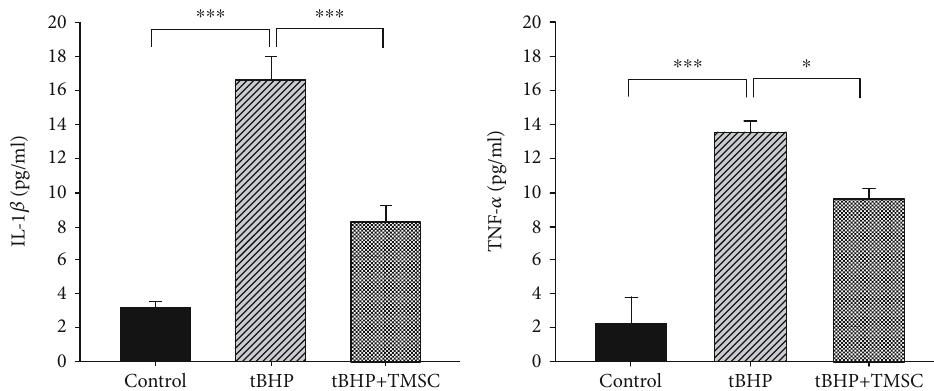
Figure 4: The dynamic changes in expression of in fl ammatory cytokines during oxidative stress responses. The expression of the representative in fl ammatory cytokines, IL-1 β and TNF- α , was found to be signi fi cantly upregulated in tBHP-treated hVFFs yet downregulated following coculture with TMSC. Results are 3 technical replicates of TMSC from one donor. Representative results from two di ff erent TMSCs with similar tendency were presented. For multigroup comparison, ANOVA followed by the Bonferroni post hoc test was used for statistics. Results are shown as the mean ± SD . ∗ P < 0 : 05 , ∗∗∗ < 0 : 001